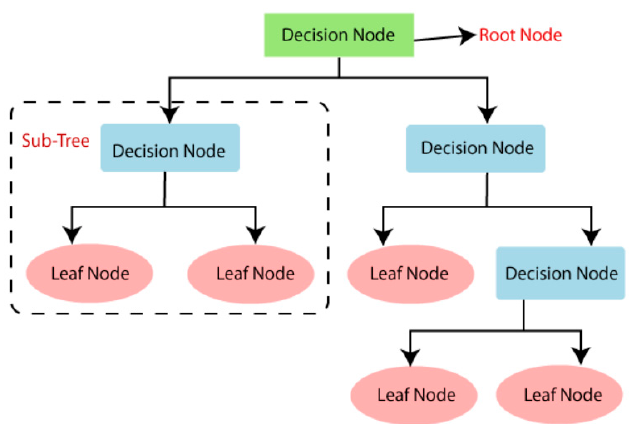
Figure 1. Structure of a general decision tree.